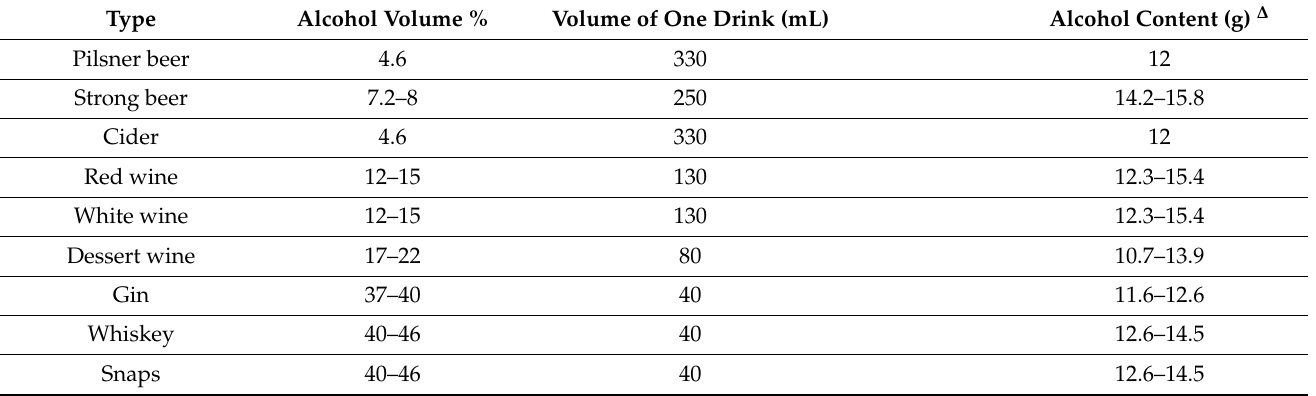
Table 1. Standard volumes of different types of alcoholic beverages corresponding to one